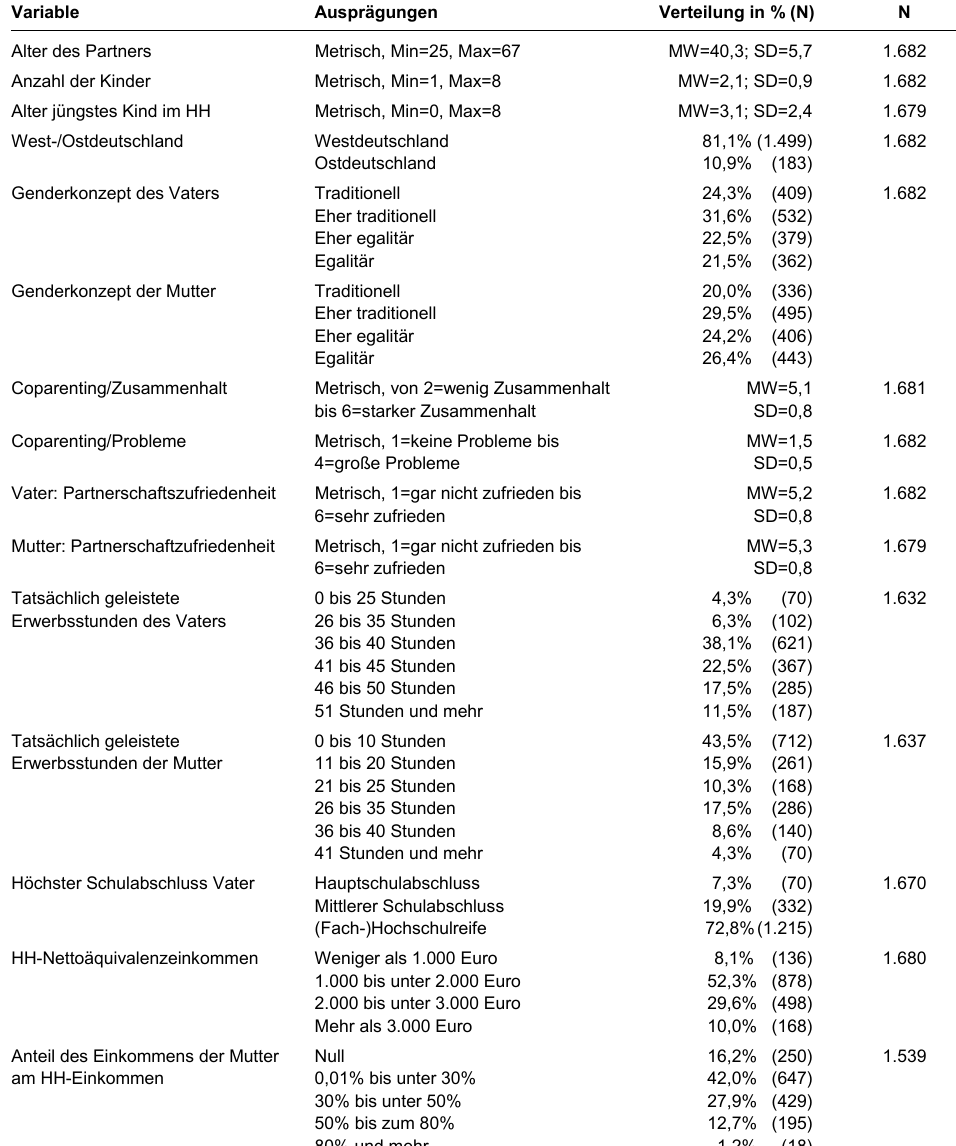
Tabelle 1 : Univariate Verteilung der unabhängigen